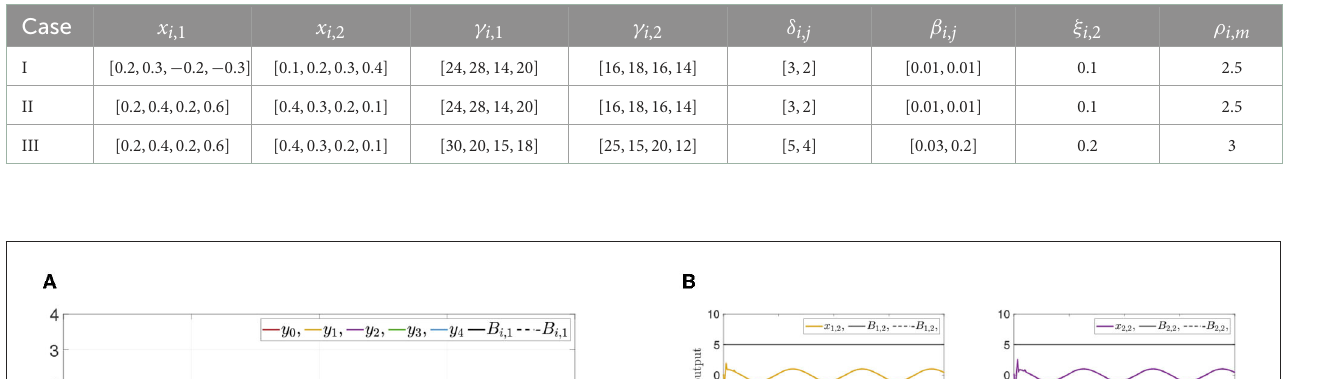
TABLE 2 System’s initial states and parameters of Example B.